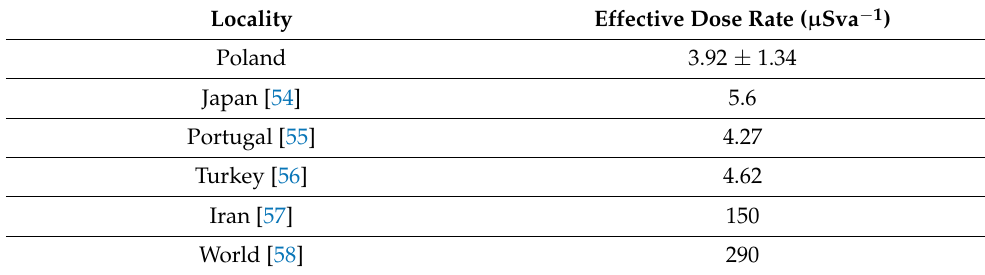
Figure 6. Annual effective dose for adults from the consumption of individual mineral waters. Adults were selected as the comparison group. Table 5 shows the average values of annual effective doses for mineral waters consumed in Poland and other countries. Table 5. Average annual doses effective for adults from uptake with drinking water in mineral water samples.